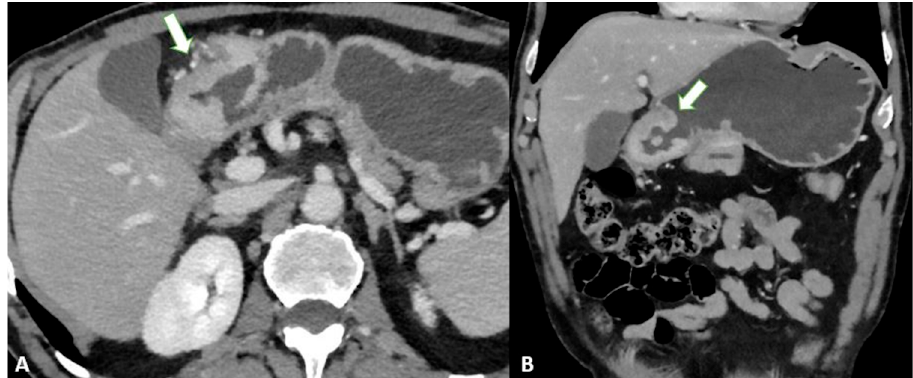
Figure 2. T3 gastric cancer in a 72-year-old male patient. ( A ) Axial 2D image in the portal venous phase and ( B ) Coronal 2D reconstruction showing wall thickening (white arrow) in the lesser cur- vature of the low body of the stomach and inhomogeneous enhancement. The tumor invades the subserosa layer without invasion of the serosa and adjacent structures.